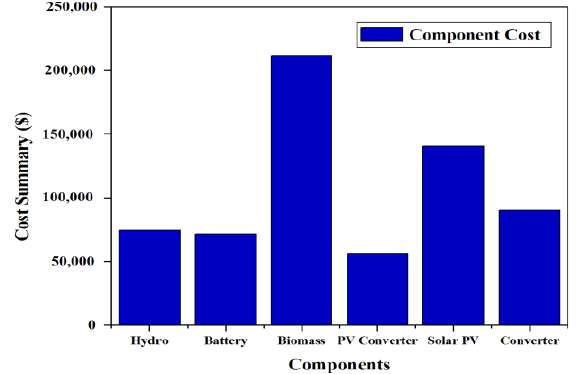
Figure 28. Total component cost breakdown for case IV (Ba/Bi/H/S).